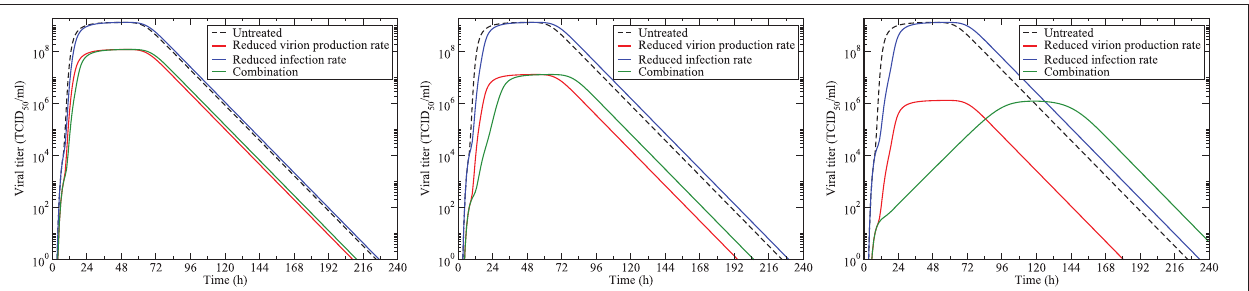
FIGURE 1 | Model simulations of antiviral treatment. The untreated infection is given by the black dashed line. Monotherapy with an antiviral reducing virion production is shown in red. Monotherapy with an antiviral reducing the infection rate is shown in blue. The combination of the two (at the same doses) is shown in green. The left panel shows infections when the antiviral is treated with doses of 10 × IC 50 ; the center panel shows doses of 100 × IC 50 ; and the right panel shows doses of 1,000 × IC 50